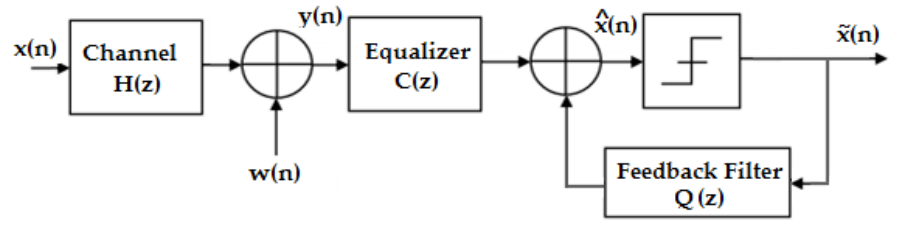
Figure 5. Diagram of a nonlinear equalizer [15].